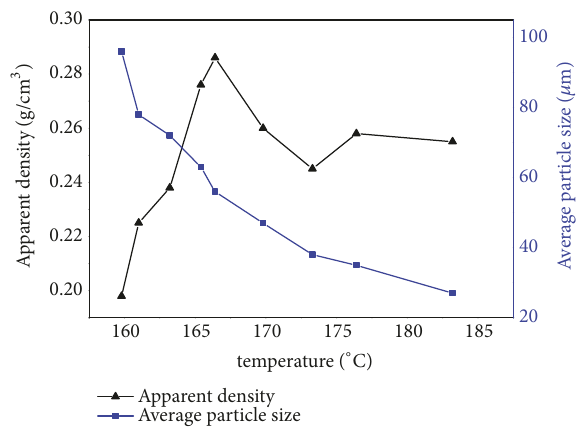
Figure 2: Plots of average particle size diameter and apparent density of PP powders versus solid-to-solvent ratio (dissolution temperature 166 ∘ C).